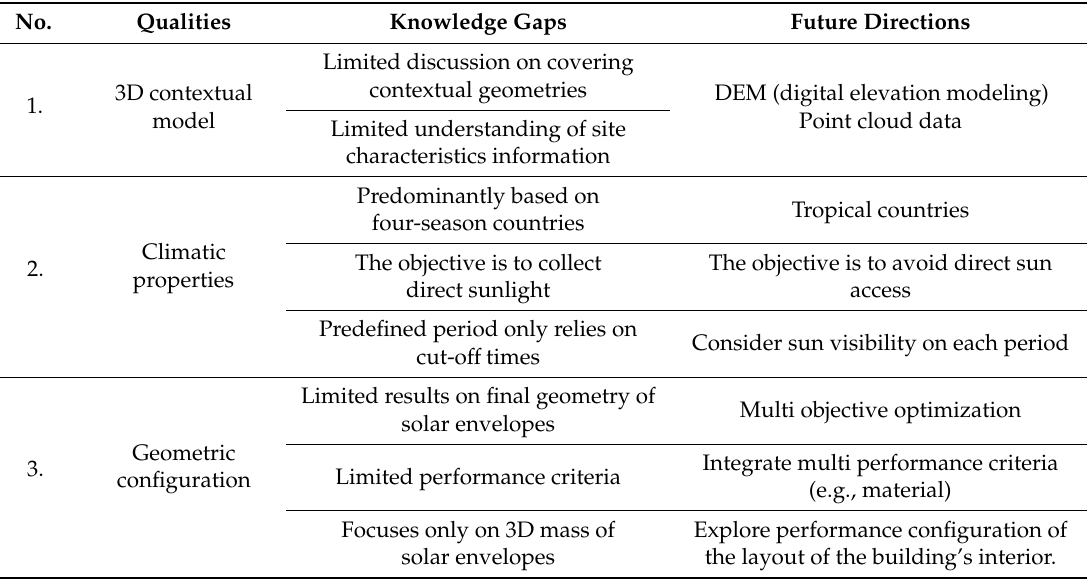
Table 3. Knowledge gaps and new directions for solar